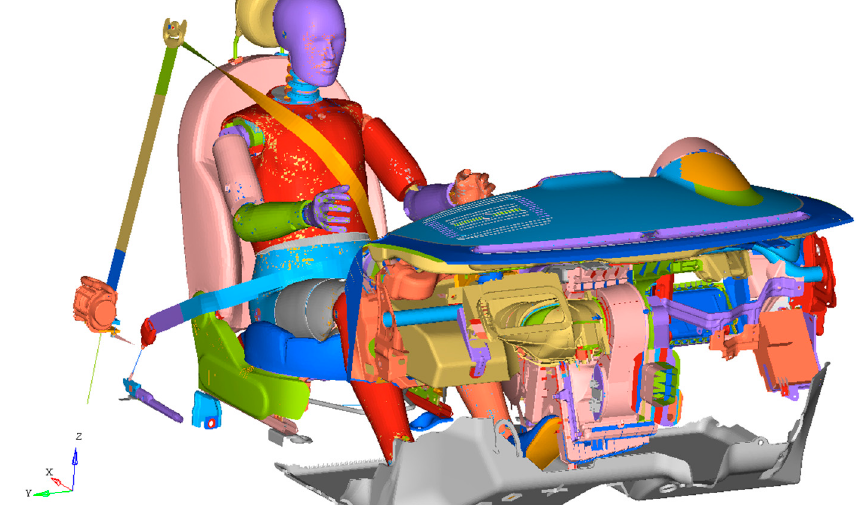
Figure 7. FEM of dummy-dashboard system.